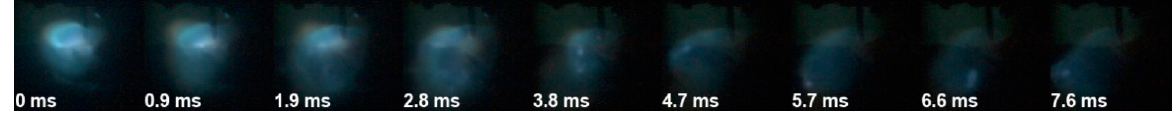
Figure 7. CSC cathode spot wandering.